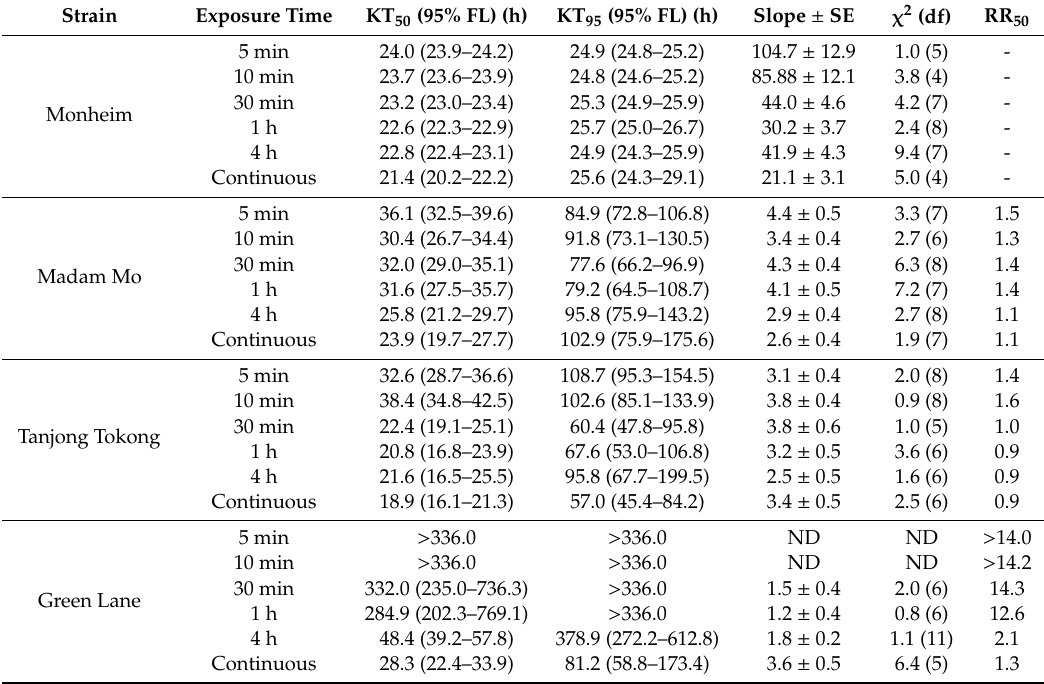
Table 5. The KT 50 and KT 95 values of a susceptible C. lectularius strain and three C. hemipterus field strains tested using Phantom applied at label